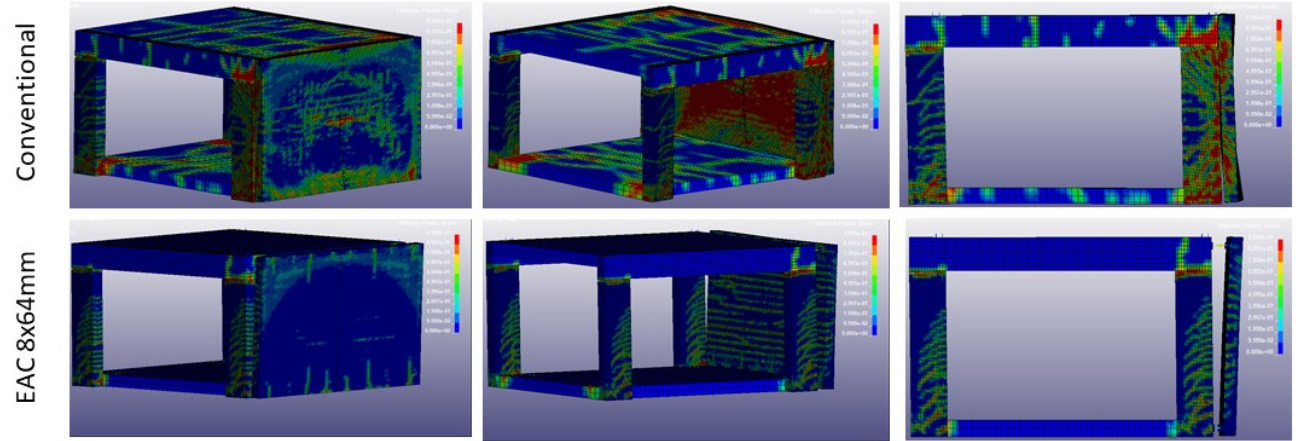
Figure 19. Effective plastic strain scenario (i): 150 kg TNT at 5 m